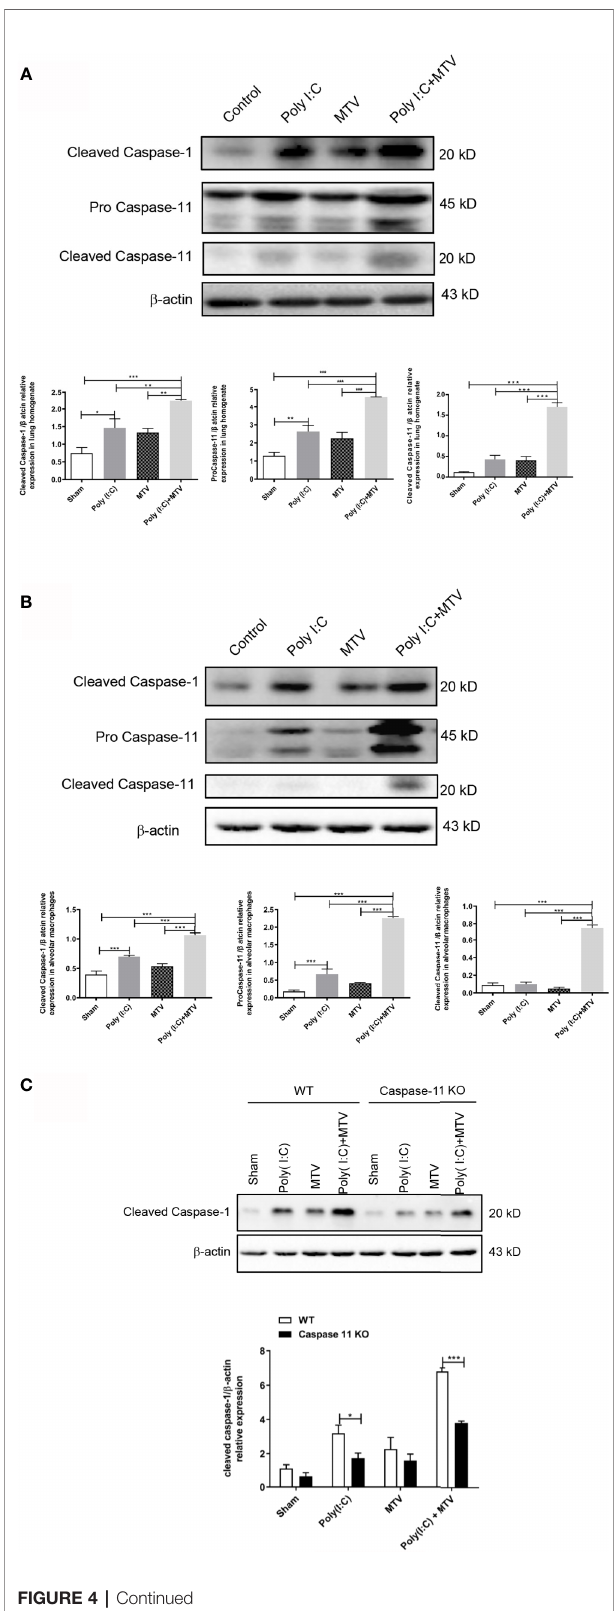
FIGURE 4 | Alterations of protein levels of cleaved caspase-1, procaspase-11 and cleaved caspase-11 following Poly(I:C)-MTV. MTV following Poly(I:C) instillation resulted in a signi fi cant increase in procapase-11 and, large increase in appearance of cleaved caspase-11 in whole lung (A) and alveolar macrophages (B) . Cleaved caspase-1 expression levels were inhibited in caspase-11 KO mice in Poly (I:C)-MTV compared to that in WT mice (C) . Results are shown as means ± SEM (n=12) and compared by one-way ANOVA and Student-Newman-Keuls test. * p < 0.05, ** p < 0.01, *** p